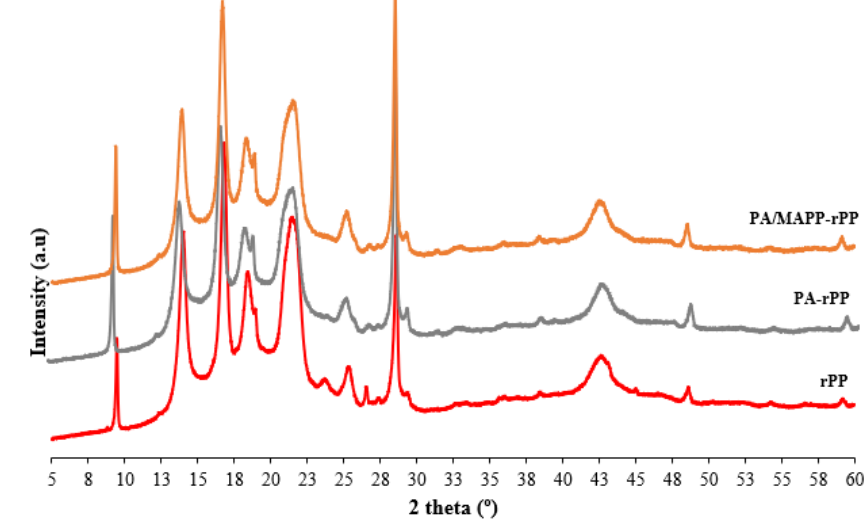
Figure 12. XRD pattern of rPP, PA-rPP and PA/MAPP-rPP.